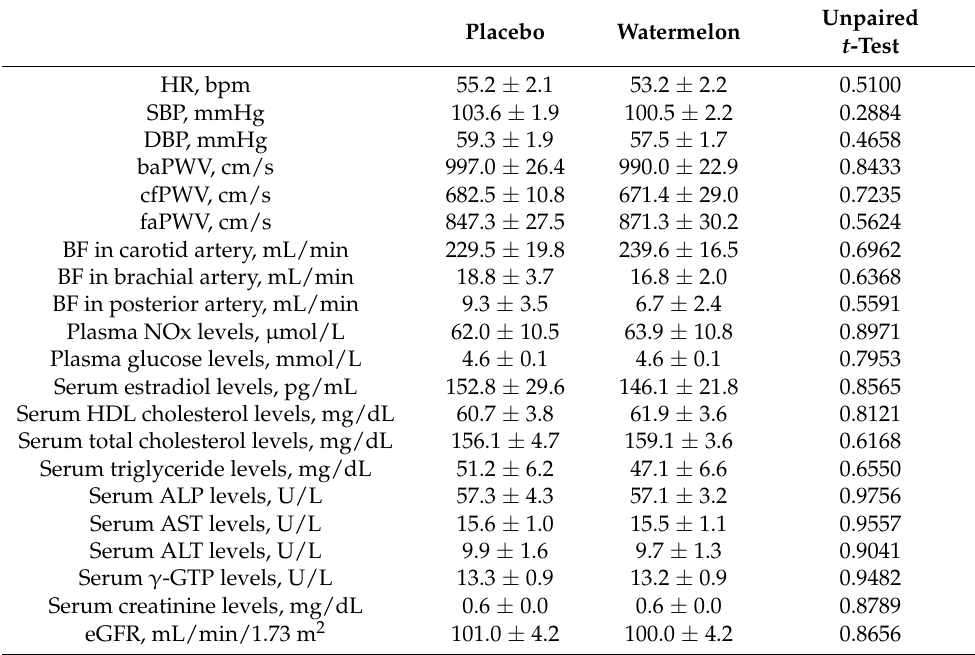
Table 1. Comparison of characteristics in placebo and watermelon intake